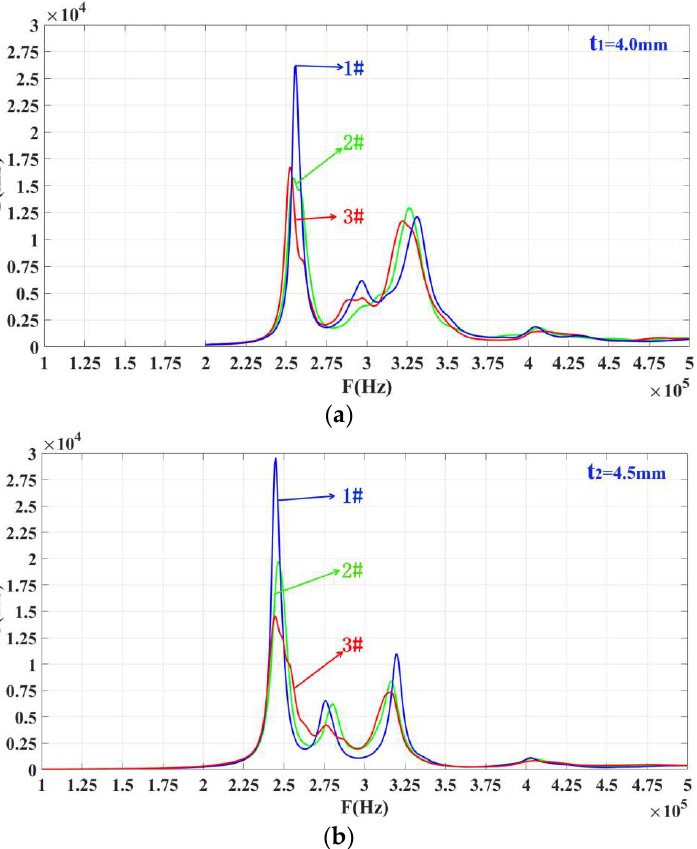
Figure 8. Conductance curves of sensitive components with two different thicknesses. ( a ) t 1 = 4.0 mm, ( b ) t 2 = 4.5 mm.